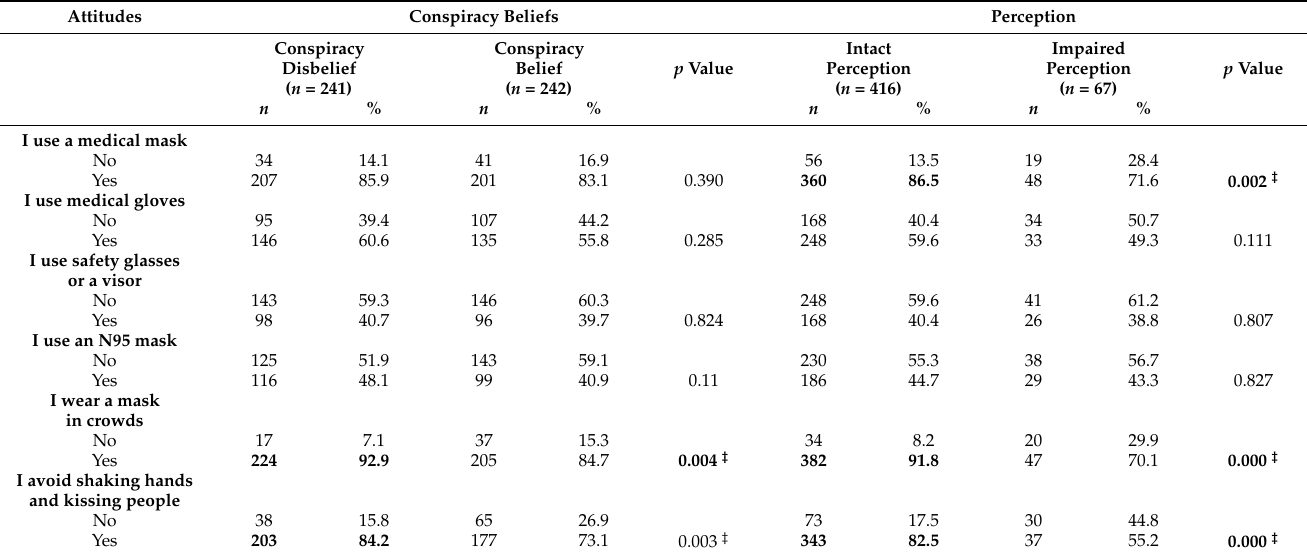
Table 5. The association of COVID-19 perceptions/conspiracy beliefs with